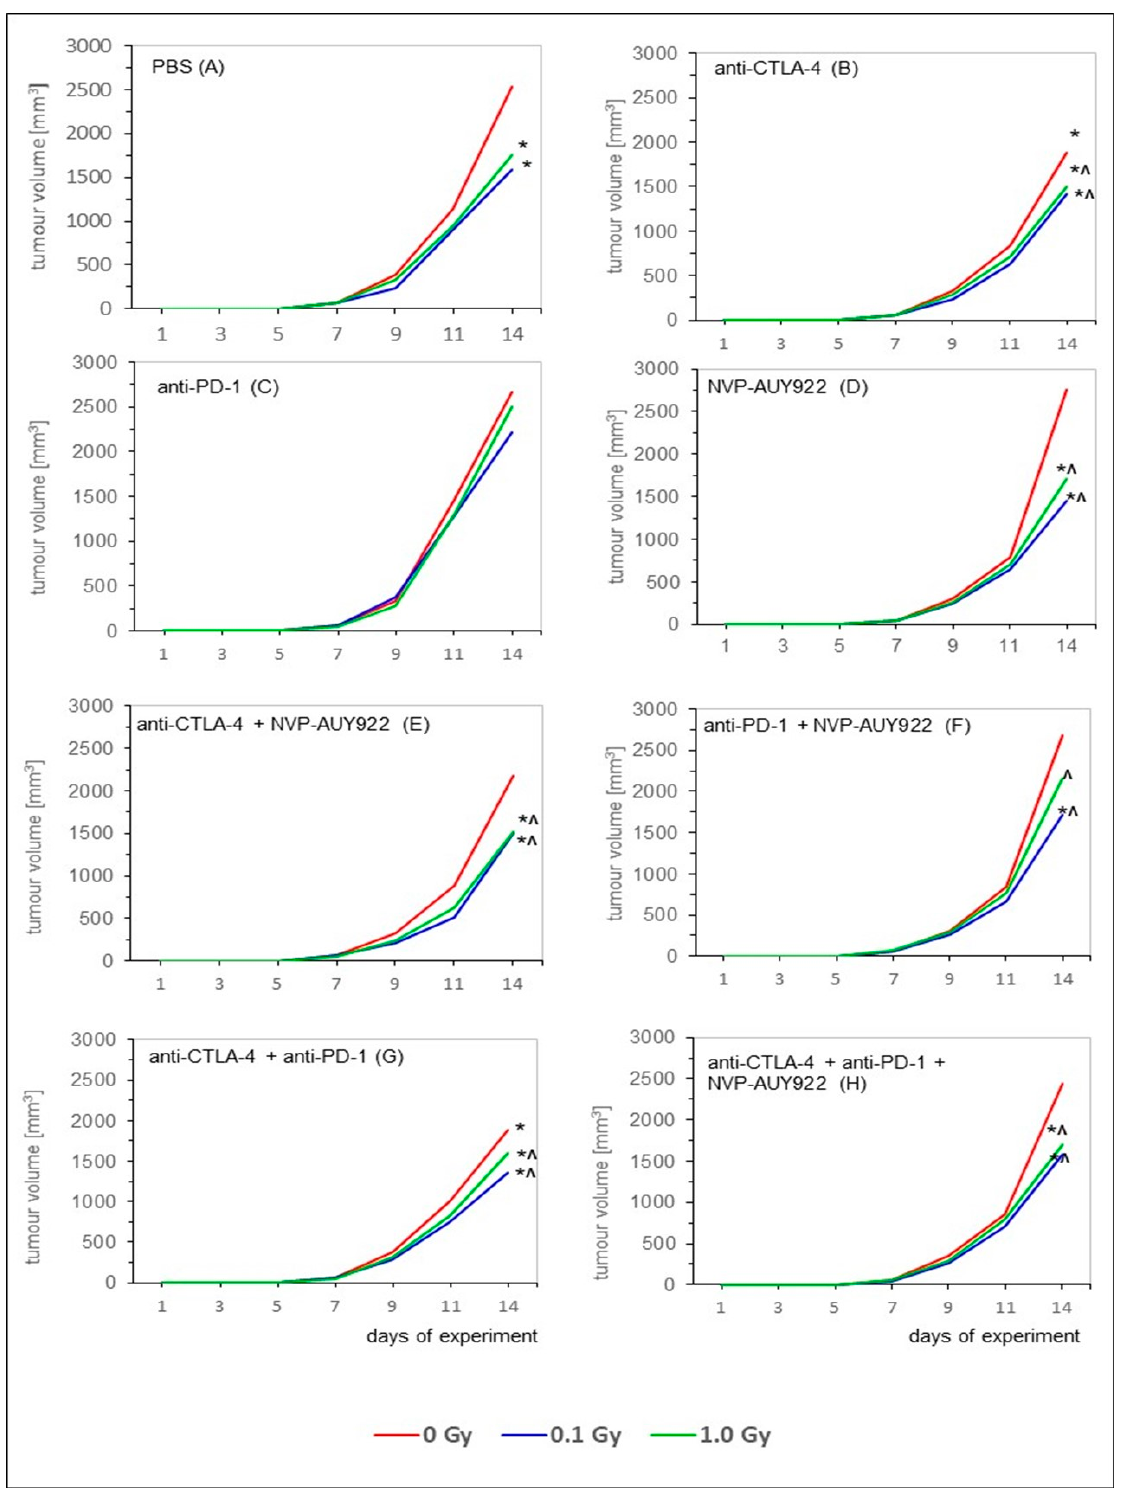
Figure 3. Tumor growth in C57BL/6 mice s.c. injected with LLC1 cells and exposed to WBI at total doses of 0.1 or 1.0 Gy combined with the blockade of the function of one or two immune checkpoints and/or HSP90. The curves formed from mean values of the tumor volumes measured in 6 mice per group are presented. * indicates statistically significant ( p < 0.05) difference from the results obtained in the sham-exposed mice injected with PBS; ^ indicates statistically significant ( p < 0.05) difference from the results obtained in the sham-exposed mice injected with the same molecule or combination of the molecules.